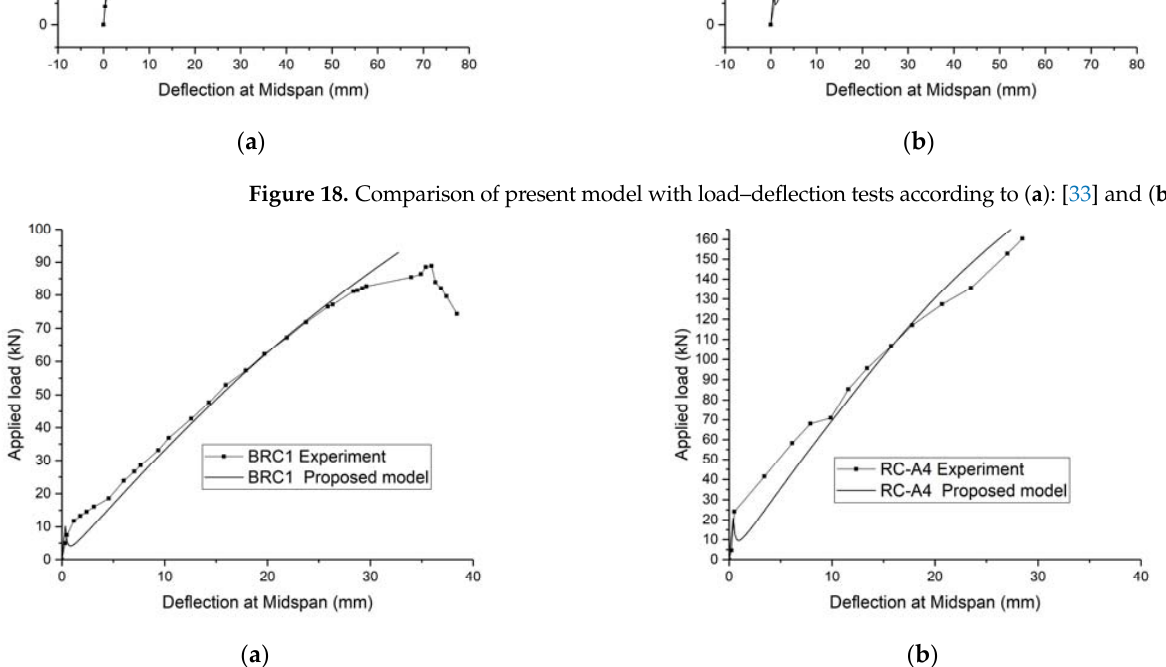
Figure 19. Comparison of present model with load–deflection tests according to ( a ): [35] and ( b ): [36].